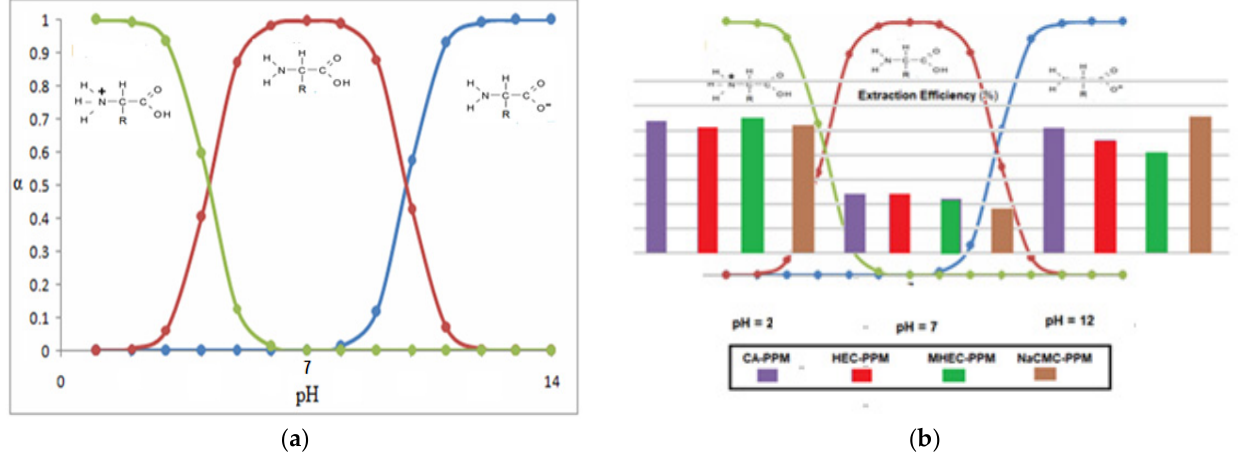
Figure 19. The speciation diagram of an amino acid, as a function on pH: ( a ) diagram; and ( b ) the diagrams superimposed over the extraction efficiency graph from Figure 17.